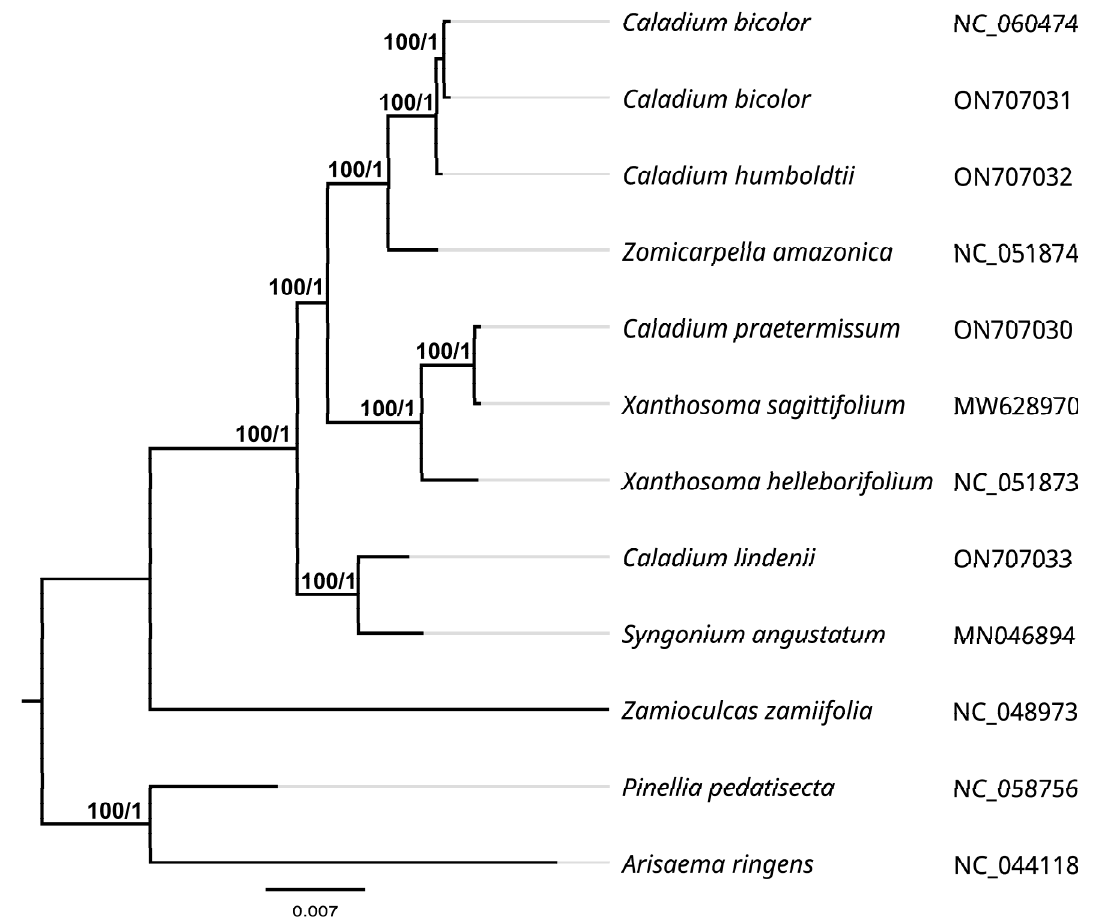
Figure 6. Maximum likelihood (ML) phylogenetic tree construction, including twelve species based on concatenated sequences from all chloroplast genomes. The obtained bootstrap values (BS) and Bayesian inference posterior probabilities (PP) are marked at the tree node (BS/PP).